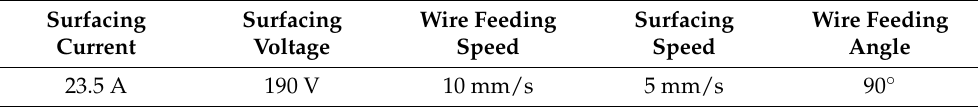
Table 1. Surfacing parameters.